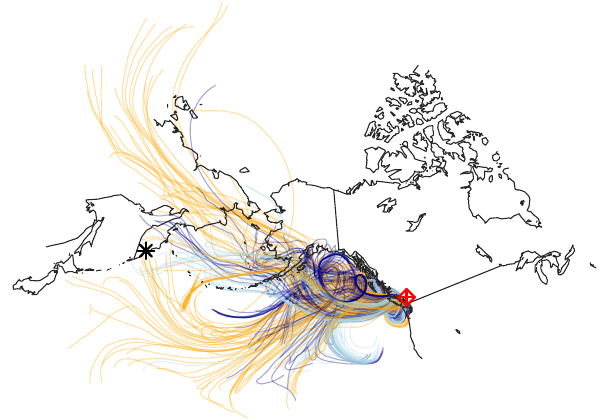
Fig. 12. Seven-day HYSPLIT backtrajectories between 21 to 24 August colored by initial altitude (a.g.l.): 500m=dark blue, 1000m=light blue, 2000m=orange. Red diamond marks Whistler Peak (at 2182m); black star marks the location of the Kamchatkan volcano